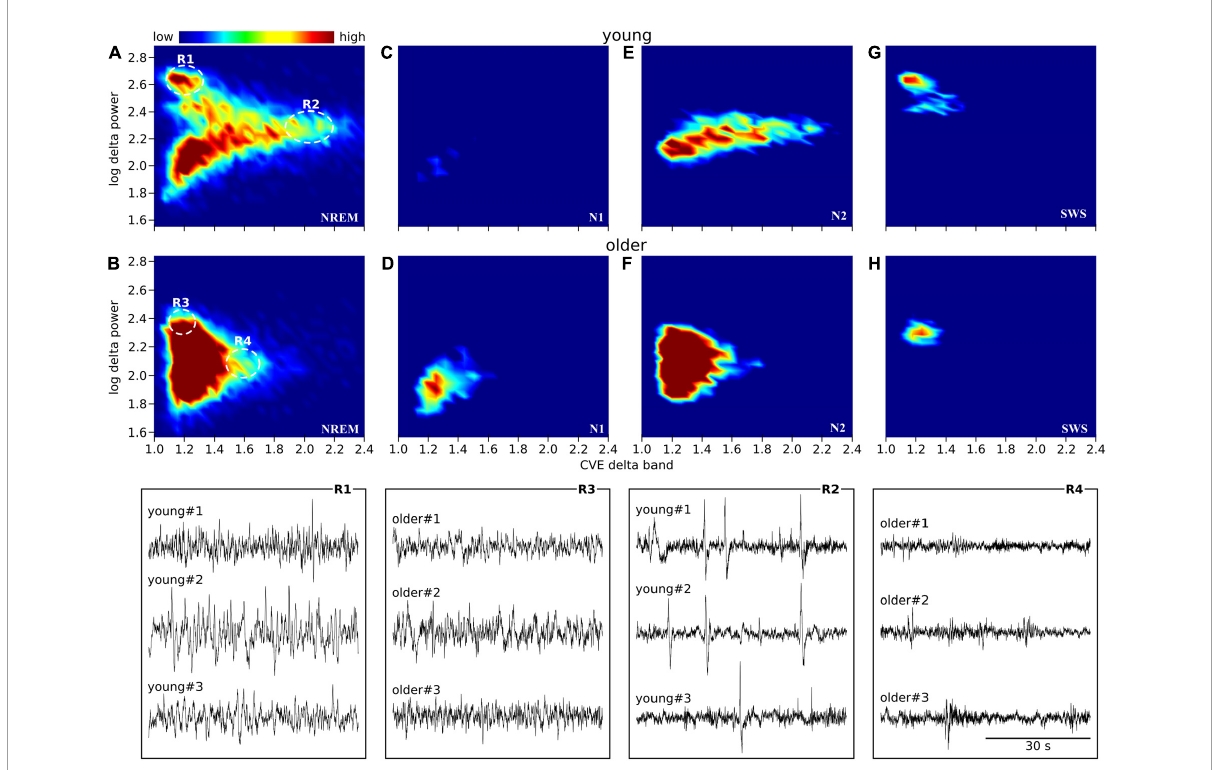
FIGURE5 Envelope characterization space (ECS) of EEG delta band during NREM sleep. Upper panels (A–H) show the ECS -i.e., CVE vs. amplitude- of the EEG delta band as density plots (2D histograms) of pooled young subjects (first row) and older subjects (second row). Panels (A,B) correspond to the ECS considering all NREM epochs. Panels (C,D) only N1 epochs. Panels (E,F) only N2 epochs. Panels (G,H) only SWS (N3) epochs. Notice that while in older subjects all epochs are condensed in a single cluster (B) , younger subjects generate rich clustering patterns with evident local densities and a long tail pointing to high CVE values. Bottom traces correspond to representative EEG epochs from three young and three older subjects taken from regions 1 to 4 as indicated in panels (A,B) . In young subjects, SWS is an objectively isolated cluster of high amplitude delta waves (R1 vs. R3). In young subjects, high amplitude transients (K complexes) are observed while in the older subjects, the expected amplitude of transient delta activity is greatly diminished (R2 vs.